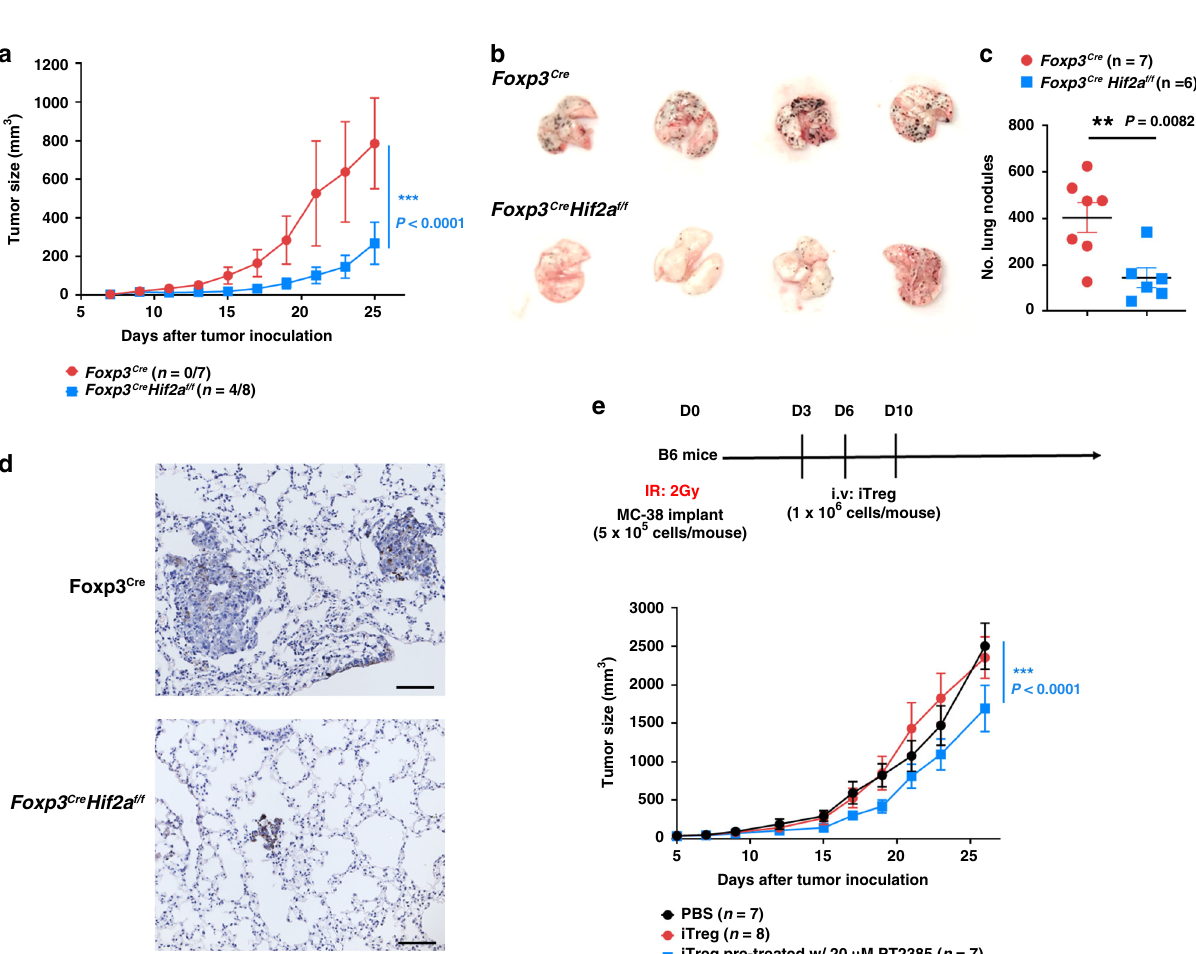
Fig. 7 Treg-speci fi c KO of HIF-2 α confers resistance to tumor growth. a Treg-conditional deletion of Hif2a inhibits MC38 growth. MC38 colon adenocarcinoma cells (1 × 10 5 ) were subcutaneously inoculated into WT ( Foxp3 Cre ) or Foxp3 Cre Hif2a f/f mice, with Foxp3 Cre being littermate controls of Foxp3 Cre Hif2a f/f mice. Tumor growth was assessed every 2 days. Plotted values represent the mean and SEM of mice with a tumor. Numbers in brackets of legend represent tumor-free mice in each group. Red circle, Foxp3 Cre ( n = 7), blue square, Foxp3 Cre Hif2a f/f ( n = 8). **** P < 0.0001. b – d Foxp3 Cre Hif2a f/f mice are resistant to B16F10 metastases. B16F10 melanoma cells (2 × 10 5 ) were intravenously administered into Foxp3 Cre and Foxp3 Cre Hif2a f/f mice, with Foxp3 Cre mice being littermates of Foxp3 Cre Hif2a f/f mice. At day 12 post-implantation, lungs were isolated b and the numbers of black nodules in lungs were quanti fi ed c . Red circle, Foxp3 Cre ( n = 7), blue square, Foxp3 Cre Hif2a f/f ( n = 6) c . ** P = 0.0082. Lung metastases were examined by H&E staining d . Bar indicates 100 μ m. e Inhibition of MC38 growth by HIF-2 α -downregulated Treg cells. Upper panel shows experimental setup. C57BL/6 male mice (6 – 8 weeks-old) were transplanted with 5 × 10 5 MC38 cells after 2 Gy irradiation on day 0. PBS, iTreg cells (1 × 10 6 ), or iTreg cells treated with PT2385 were adoptively transferred into MC38-bearing mice on days 3, 6, and 10. Tumor growth was assessed and is represented as mean tumor volume ± SEM. Black circle, PBS ( n = 7); red circle, iTreg ( n = 8); blue square, PT2385-treated iTreg ( n = 7). **** P < 0.0001. P -value was determined by repeat measures two-way ANOVA with Tukey ’ s multiple comparisons test, with the Greenhouse-Geisser correction a , e or two-tailed unpaired t -test ( c ). Source data are provided as a Source data fi